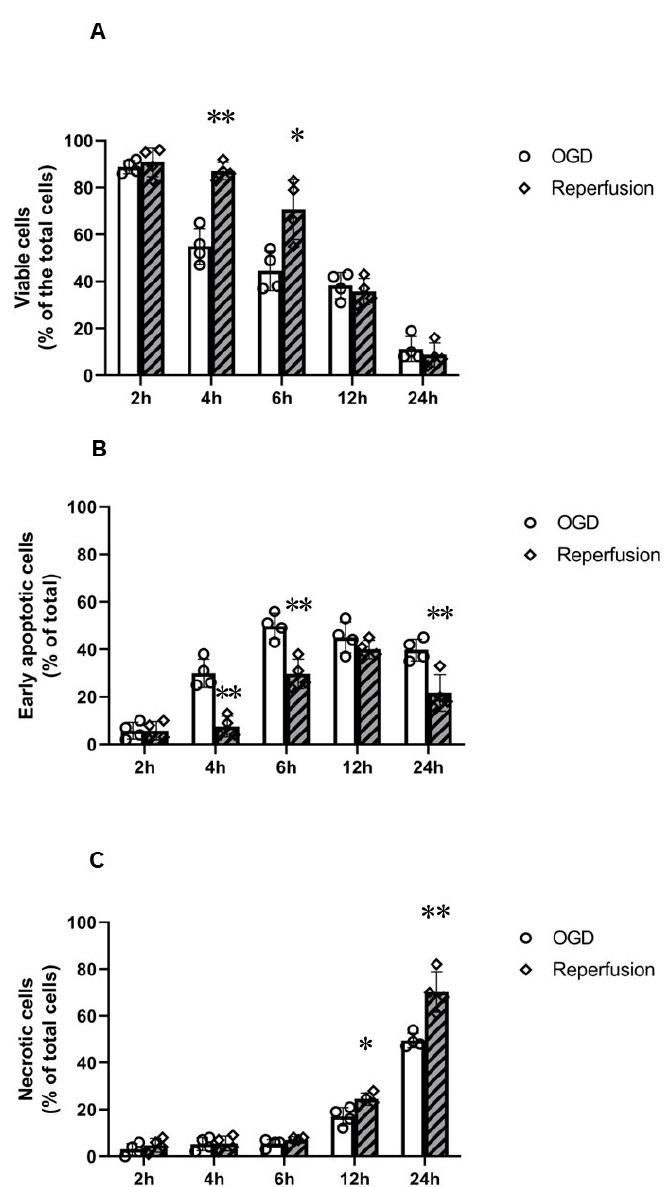
Figure 3. Annexin-V and 7-AAD FACS analysis of PC12 cells following oxygen–glucose deprivation (OGD) before and after 24 h reperfusion. ( A ) Graph of group data ( n = 4) representing % of live cells (AV − /7-AAD − ); 24 h reperfusion increased % live cells after 4 and 6 h OGD. ( B ) Graph of group data ( n = 4) representing % of early apoptotic cells (AV + /7-AAD − ); 24 h reperfusion reduced % of early apoptotic cells after 4 and 6 h OGD but increased % of early apoptotic cells after 24 h OGD. ( C ) Graph of group data ( n = 4) representing % of late apoptotic or necrotic cells (AV + /7-AAD + ); 24 h reperfusion increased % of late apoptotic or necrotic cells after 12 and 24 h OGD. Error bars represent ± S.D. * Indicates p < 0.05, ** p < 0.01, for comparison of the treatments of OGD and reperfusion. The effects of OGD on HIF-1 α protein expression in PC12 cells were studied. No significant HIF-1 α expression was found after 2 h of OGD. HIF-1 α was significantly upregulated at 4 h OGD (~4.5-fold); 6 h OGD (~3-fold) significantly upregulated HIF-1 α , but at